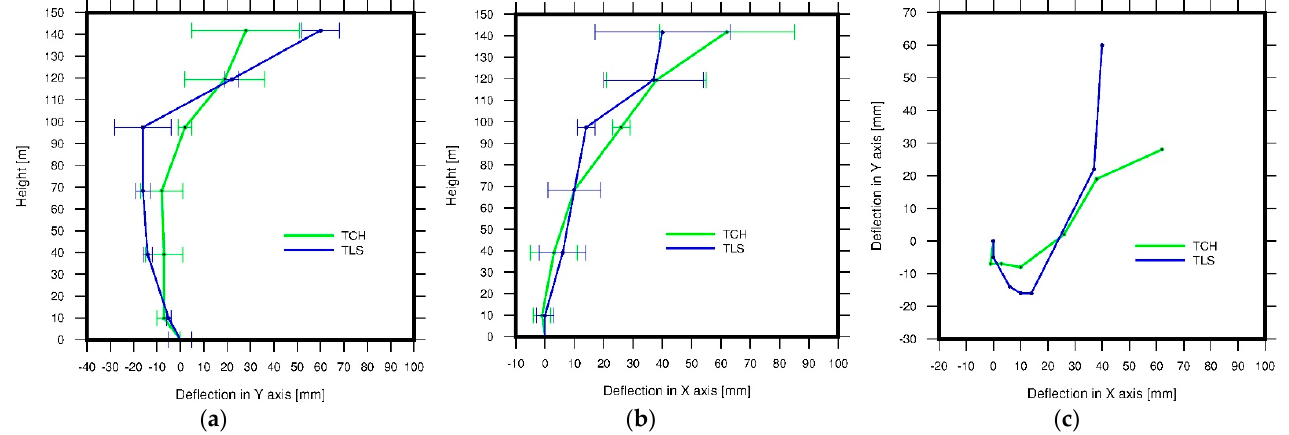
Figure 4. Deflection graphs of the wind turbine tower: ( a ) in the YZ axis, ( b ) in the XZ axis, and ( c ) in the XY axis. In XZ and YZ axis vectors are with error bar in millimeters.